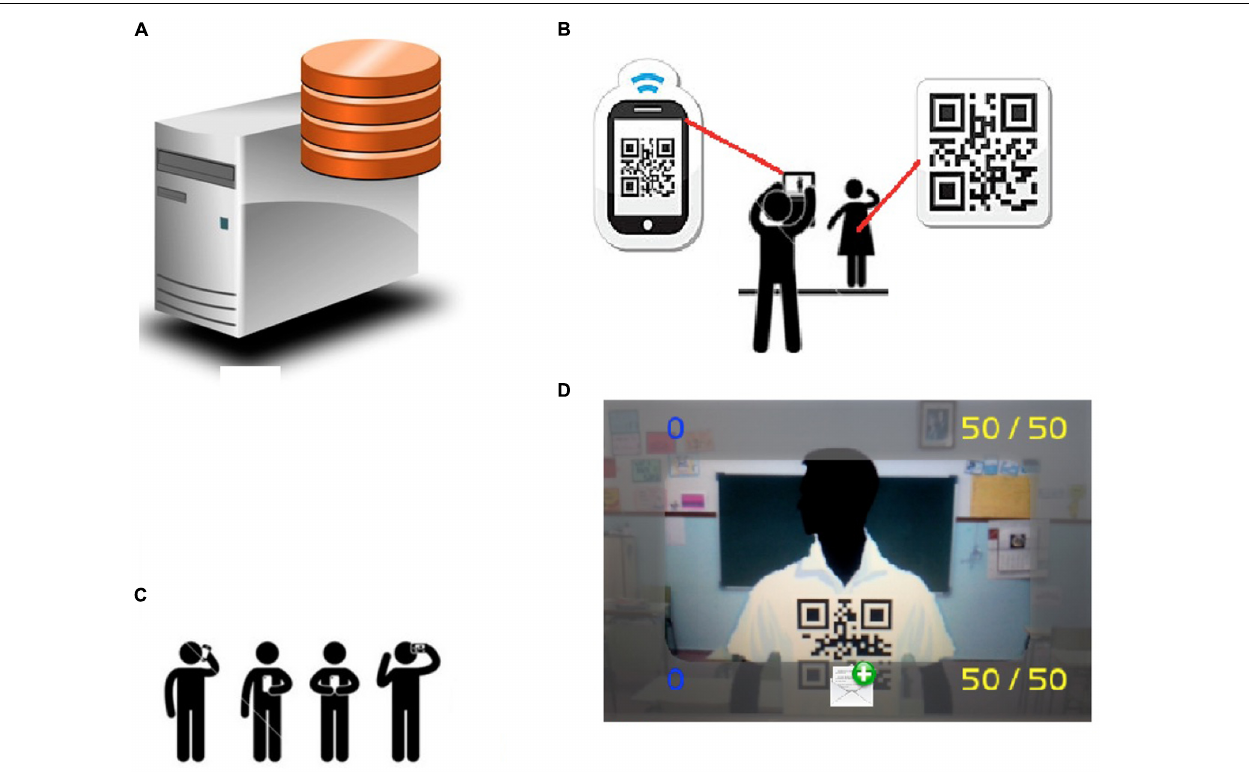
FIGURE 5 | Proposed architecture. (A) Database server. Stores the interactions. (B) How the interaction works: QR codes identify students. (C) All the students are equipped with QR and smartphones. (D) Screenshot of the game representing the interaction depicted in (B)